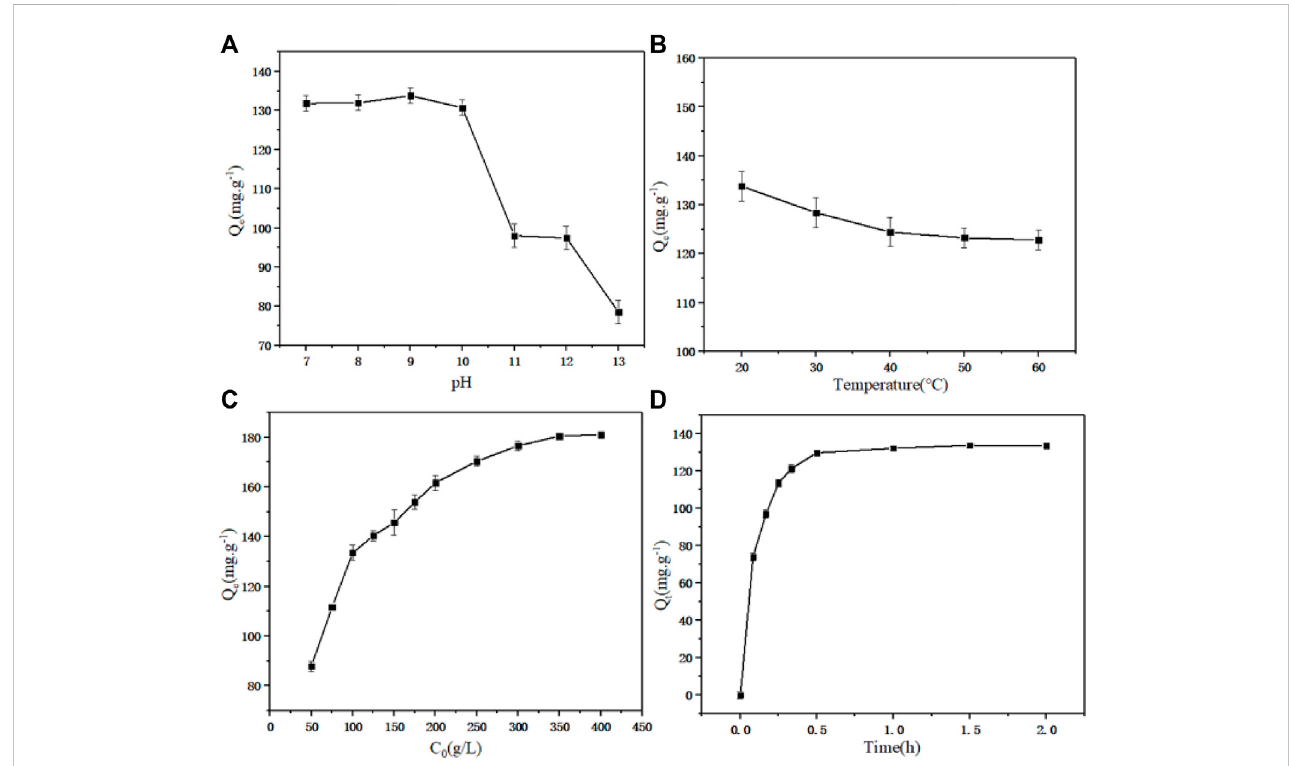
FIGURE 2 (A) EffectofpHonequilibriumadsorptioncapacity. (B) Effectoftemperatureonequilibriumadsorptioncapacity. (C) EffectofinitialconcentrationofPDA on equilibrium adsorption capacity. (D) Effect of adsorption time on equilibrium adsorption